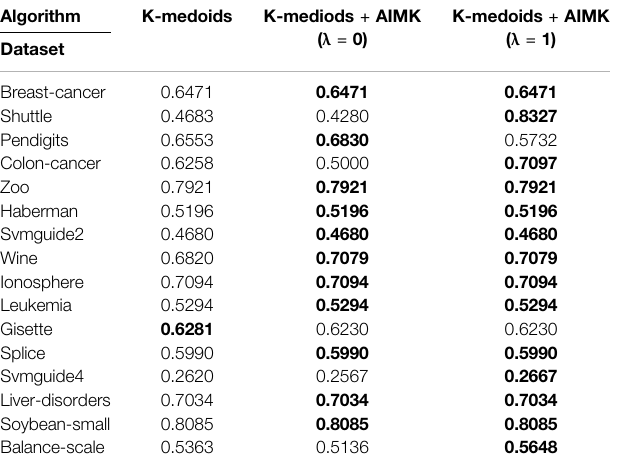
The optimal results for the corresponding dataset are denoted in